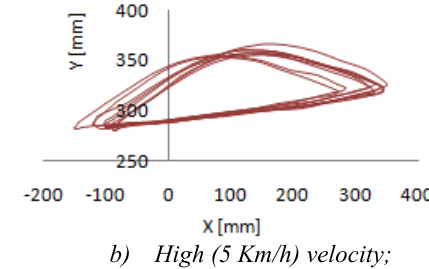
Fig. 4. Shank CoM